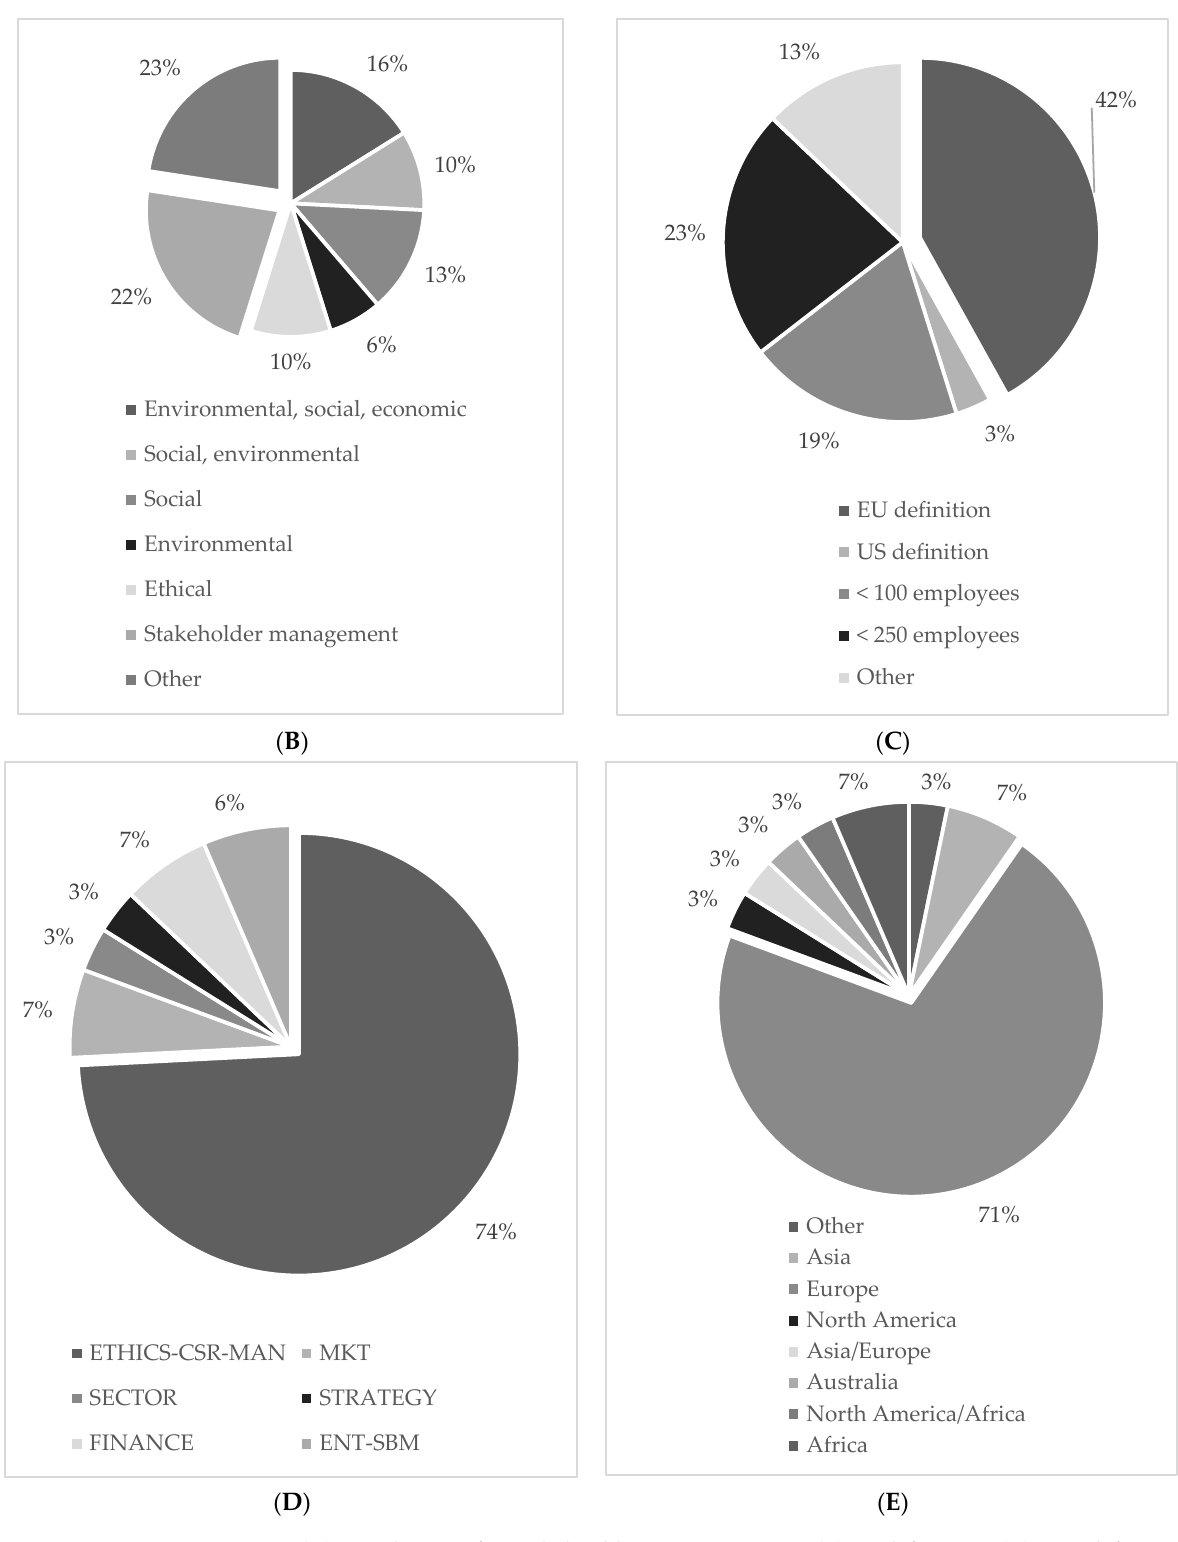
Figure 3. Descriptive statistics. ( A ) Distribution of sampled publications over years. ( B ) CS definitions. ( C ) SME definitions. ( D ) Distribution of sampled publications per research field. Note: Marketing (MKT), Management (MAN), Entrepreneurship and Small business management (ENT-SBM). ( E ) Distribution of sampled publications by geographic regions.